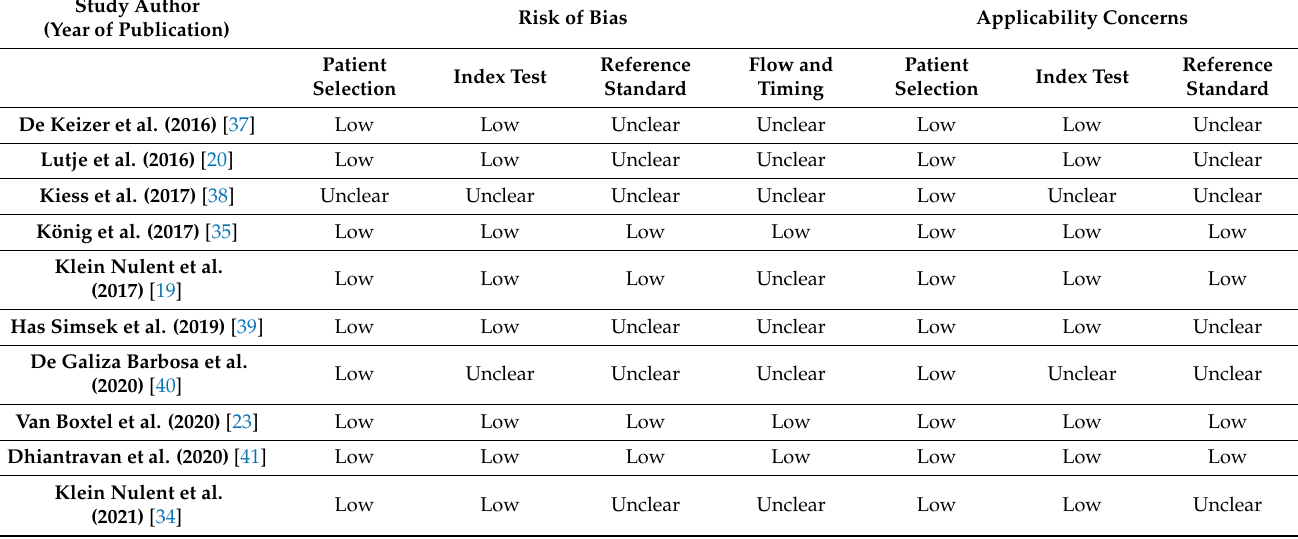
Table 3. Quality assessment of studies using the QUADAS-2